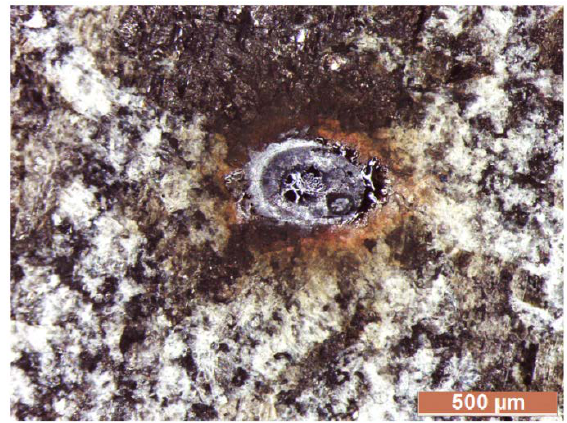
Figure 9. Optical microscopy images of orange-brown rims around a crater of dry sample A2.